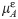
Changes in perception questions resulting from different updates of the auditory characterization of the perturbed vowel, P(AΦ | [Φ = /ɛ/]).Top and middle panels correspond to independent updates of the mean μAɛ and the standard deviation σAɛ respectively. Bottom panels correspond to a combined shift of μAɛ and reduction of σAɛ. The outcome of simulations before update (solid lines) are superimposed to those after update (dashed lines).